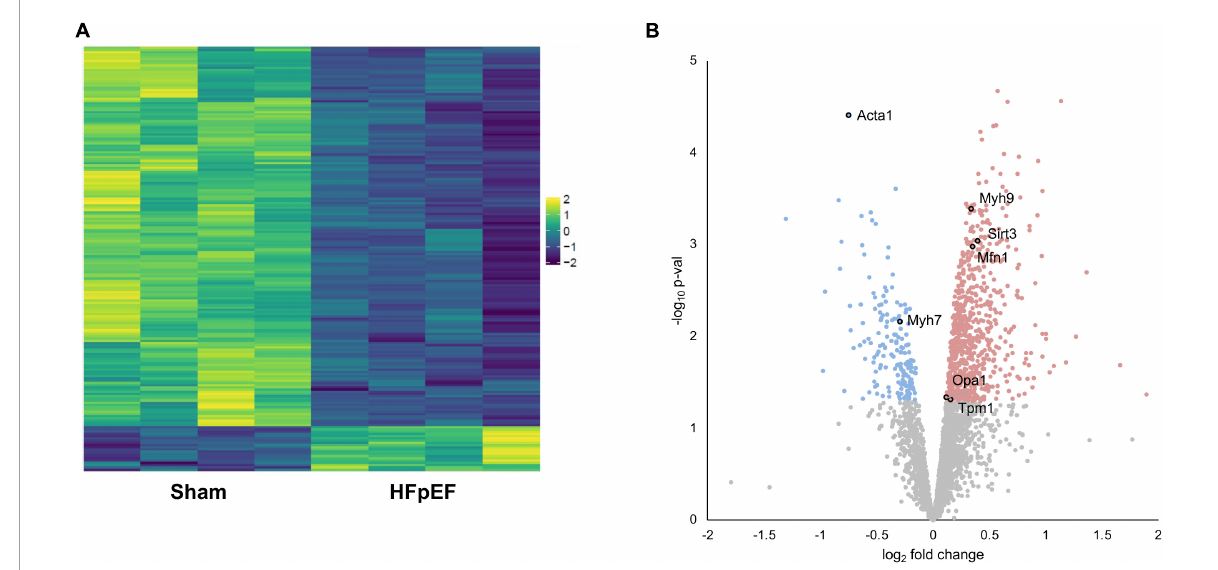
FIGURE2 Proteomics analysis. (A) Heatmap of the differentially expressed proteins. (B) Volcano plot presenting log-transformed p -values ( t -test) associated with individual significantly altered proteins plotted against log-transformed fold change in abundance between the left ventricles in Sham and HFpEF mice. Blue and red dots represent up-regulation and down-regulation in HFpEF ( N = 4) vs. Sham ( N = 4), respectively.